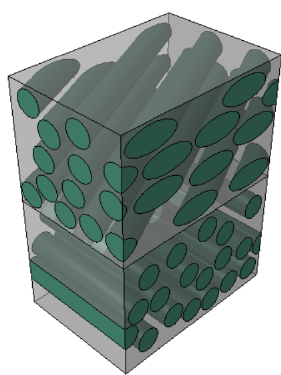
Figure 7. Mesoscopic model.